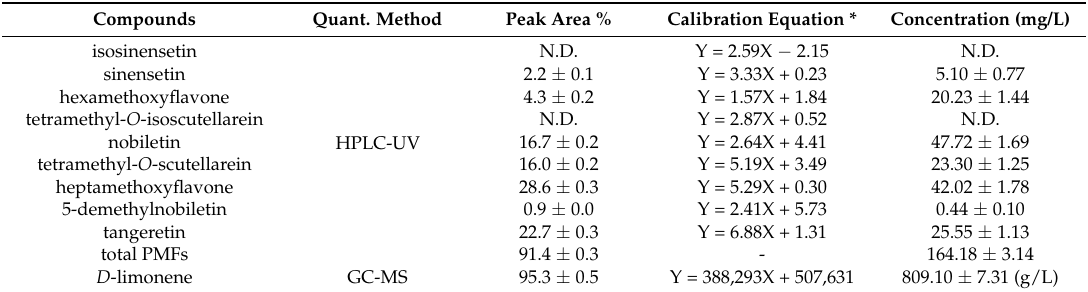
Table 2. Polymethoxyflavones and limonene contents in orange peel oil.